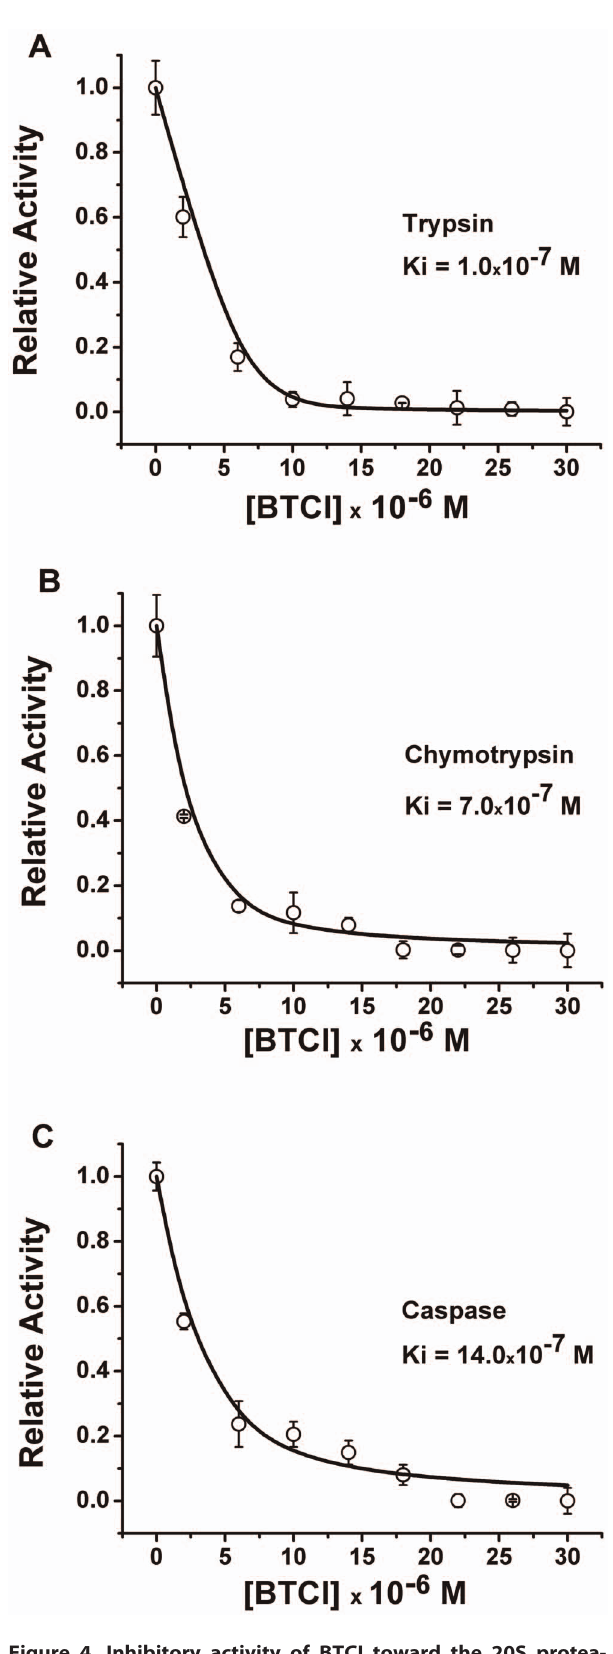
Figure 4. Inhibitory activity of BTCI toward the 20S protea- some. A) Relative activity of proteasome trypsin-like; B) Relative activity of proteasome chymotrypsin-like; C) Relative activity of proteasome